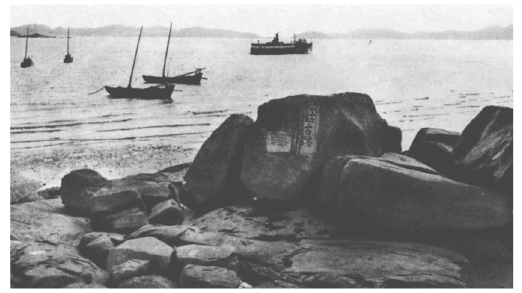
Figure 6. Stone inscriptions at Duangu Pier in 1930 (Yinguang and Zhenda 1930, p. 5).